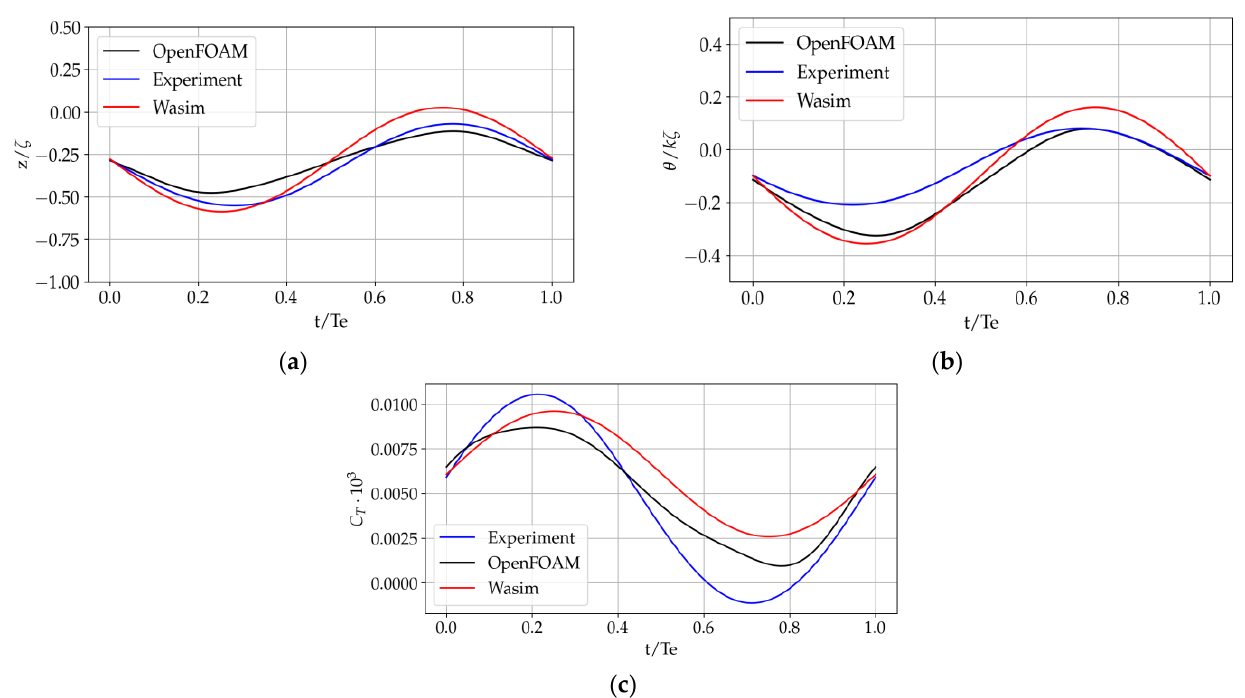
Figure 23. Time histories for case 2 of the KRISO containership: nondimensional ( a ) heave, ( b ) pitch, ( c ) total resistance.